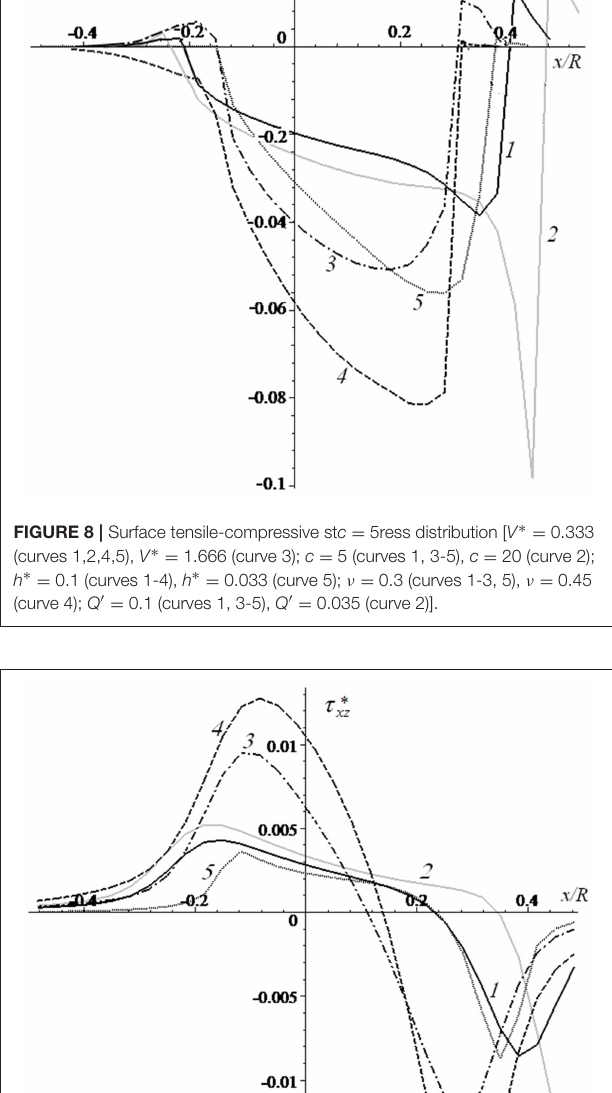
distribution becomes almost symmetrical.